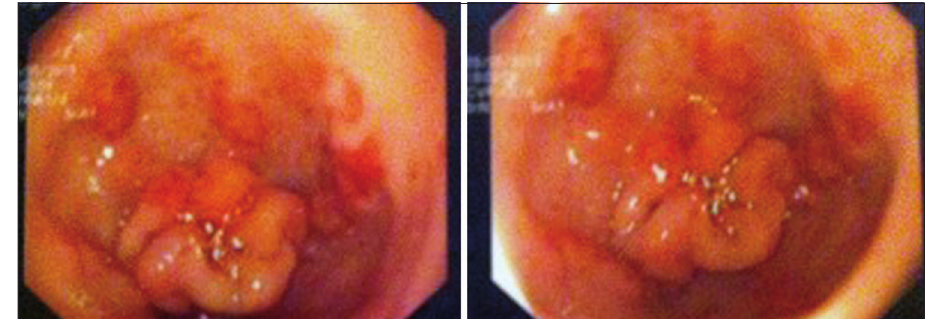
Figure 2. Control endoscopic image – GAVE still present - Four months after the first exam – the same findings still